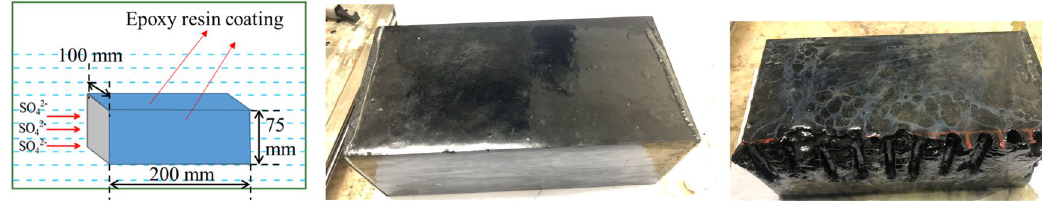
Fig. 2 Coal sample preparation and